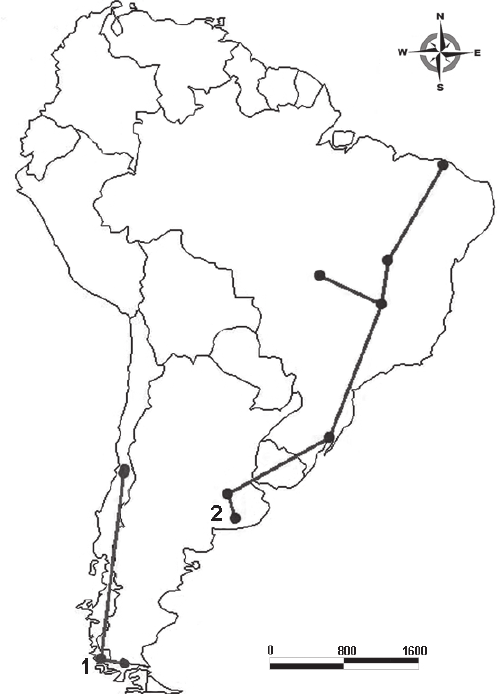
Fig. 8 - Individual tracks of Hippidion (1 - Hippidion saldiasi ; 2 - H. principale ).